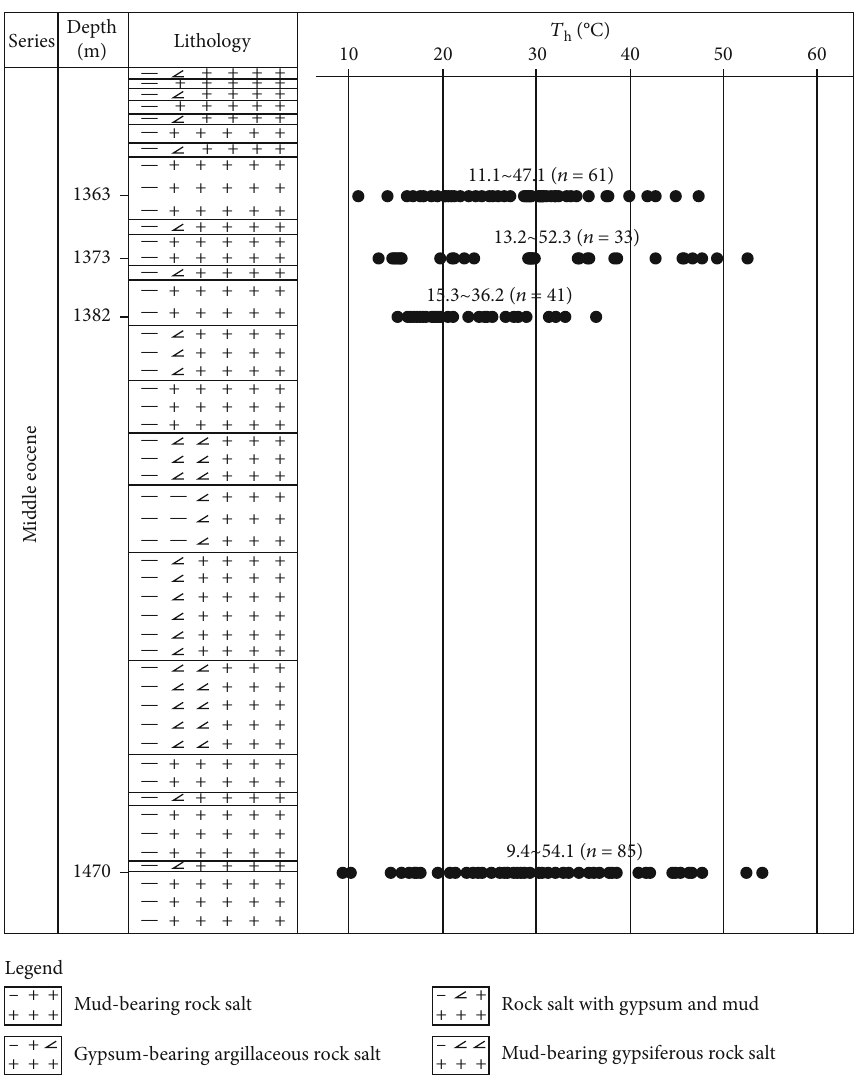
fl uid inclusions from middle Eocene halite in borehole DZK01, Kuqa Figure 6: T h data characteristics of primary